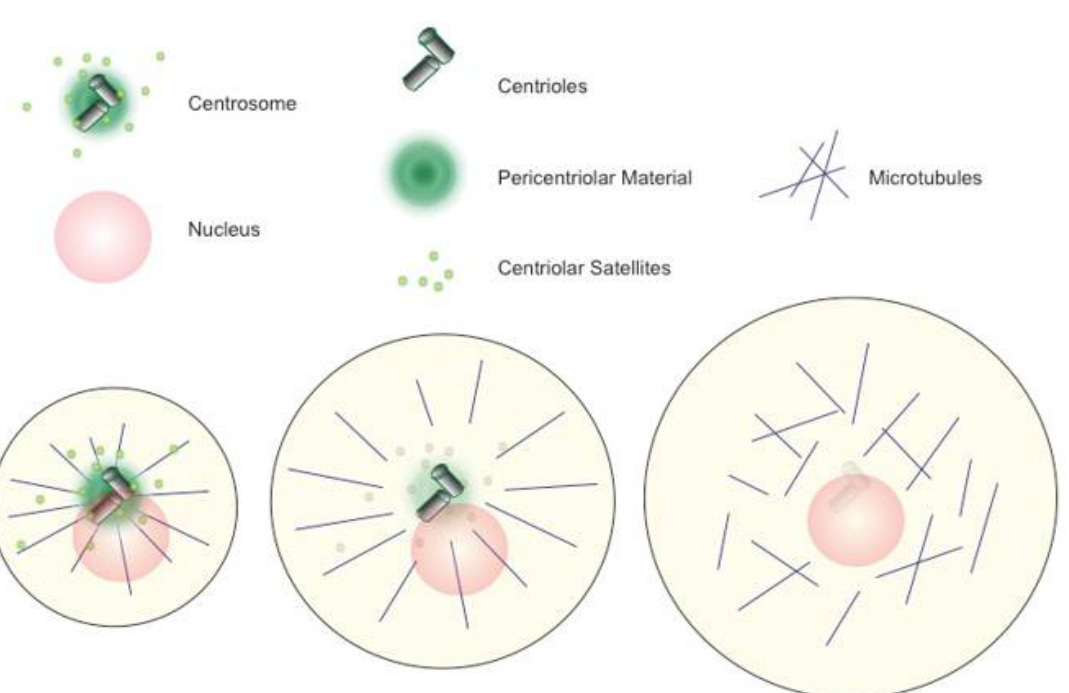
Figure 1. Loss of centrosomes during metazoan oogenesis. During their long growth phase, metazoan oocytes eliminate centrosomes. Elimination starts from the pericentriolar material (PCM) and ends with depletion of centrioles, mostly before entry into meiosis.